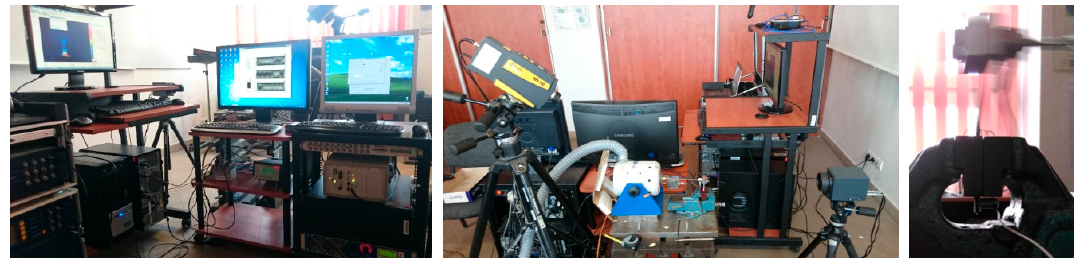
Figure 5. Laboratory test rig used for the determination of criticality of the self-heating effect.